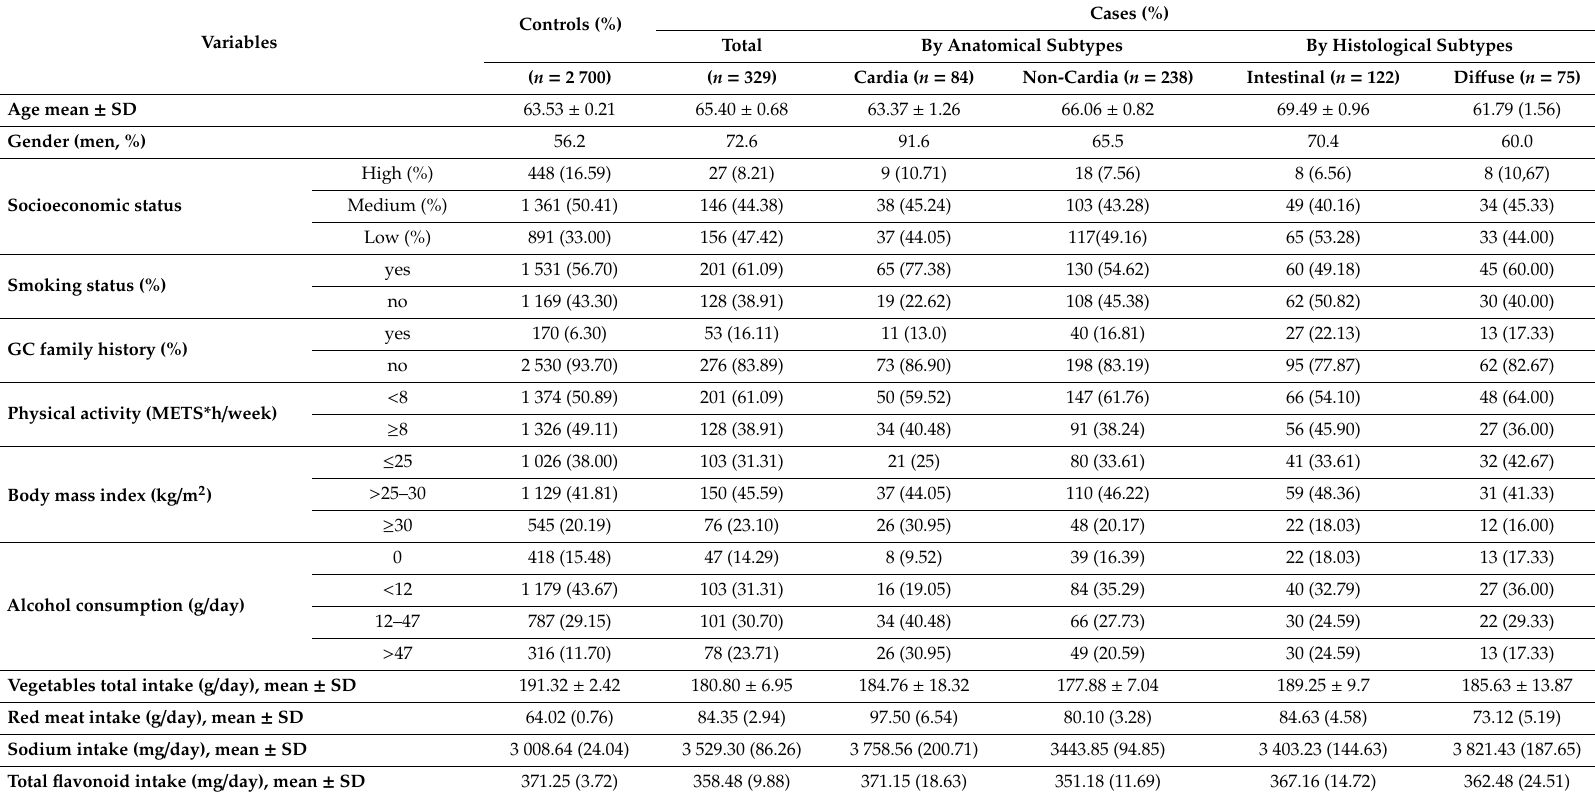
Table 1. Characteristics of the study